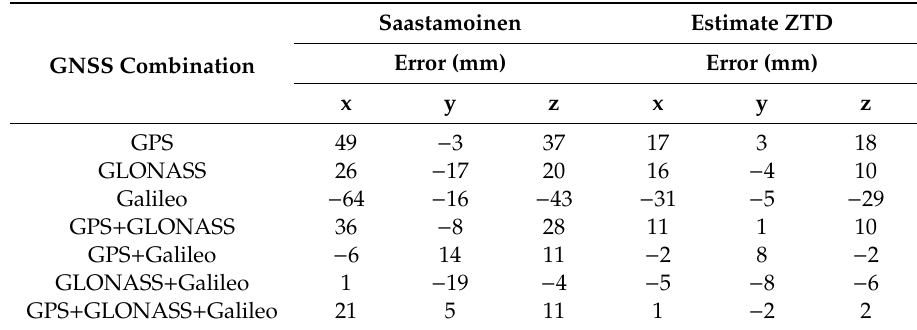
Table4. ErrorsoftheconsideredGNSScombinationswithSaastamoinenandEstimateZTDtropospheric models (outlier